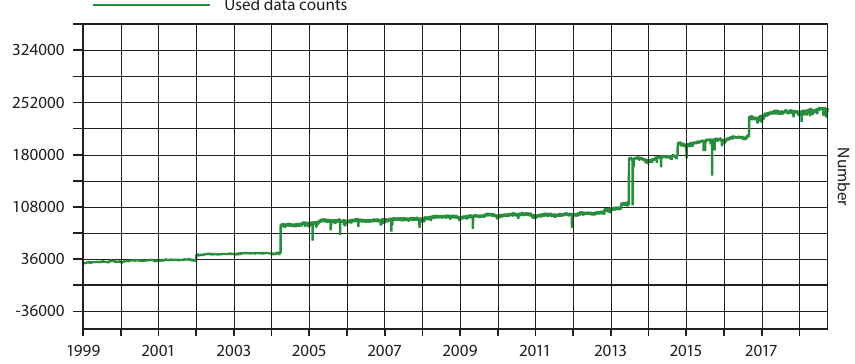
Figure 5. Daily global data counts from SYNOP and METAR observations. The sudden increase of data counts in 2013 is related to the inclusion of existing METAR observations not previously